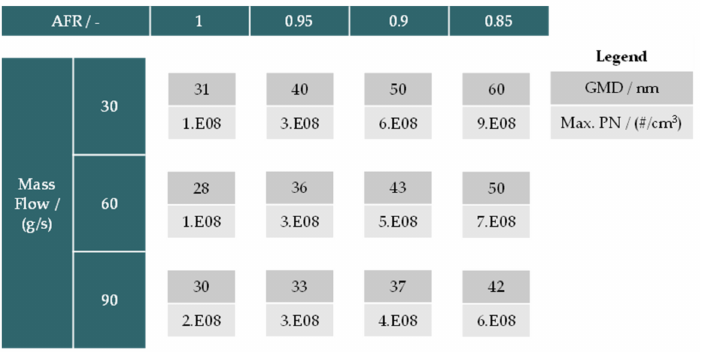
Figure 8. Spectral density curves, obtained at the burner test bench, at AFR = 0.95 considering exhaust gas temperature variations: ( a ) T exh = 500 ◦ C; ( b ) T exh = 600 ◦ C; ( c ) T exh = 700 ◦ C; ( d ) T exh = 800 ◦